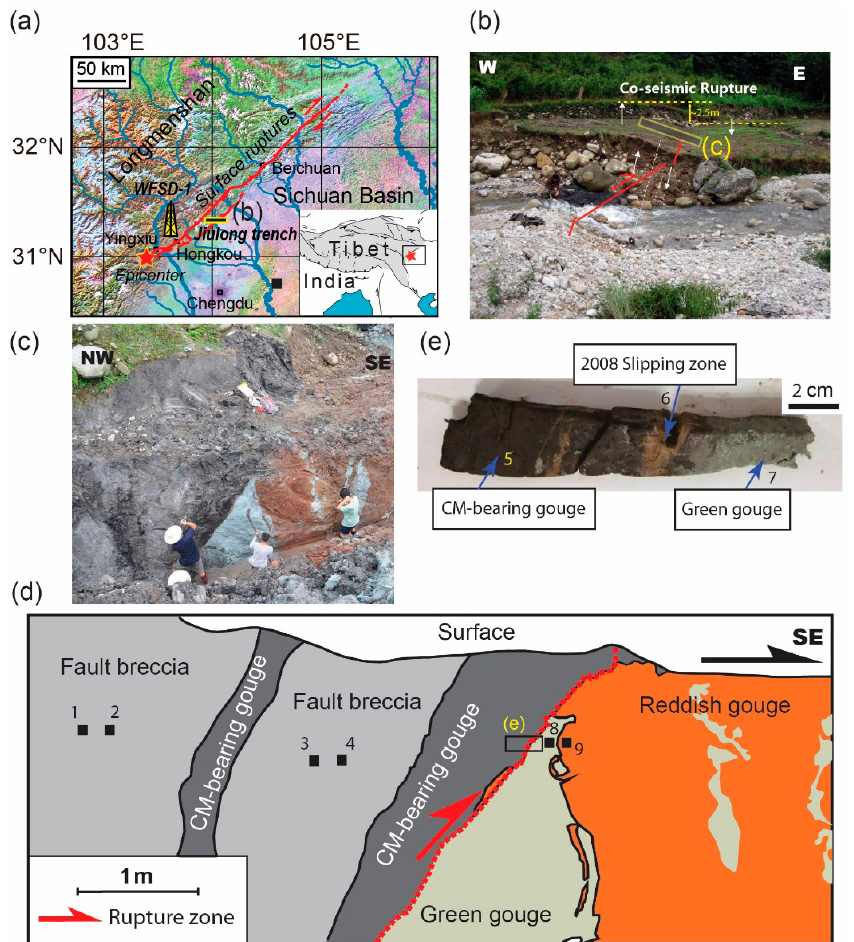
Figure 1. Map and images showing the front Longmenshan fault zone, the coseismic surface rupture zone formed in the 2008 M W -7.9 Wenchuan earthquake in China, the trench of the Anxian-Guanxian fault, and a collected fault sample. ( a ) The two surface rupture zones associated with the M W -7.9 earthquake and the location of the Wenchuan Earthquake Fault Scientific Drilling Project (WFSD-1) site. The red star is the epicenter of the main shock. The inset is a schematic of the Tibetan Plateau. The yellow area shows the location of ( b ). ( b ) The Anxian-Guanxian surface rupture outcropped at the town of Jiulong. The largest vertical displacement along the Anxian-Guanxian fault surface rupture was approximately 4 m and located in the Qingquan village; the vertical offset was approximately 2.5 m at the trench site during the Wenchuan earthquake. The yellow rectangle shows the trench construction site of ( c ). ( c ) Image of the trench. ( d ) Sketch of the trench; the numbers label the samples, and the black box shows the sampling location of sample numbers 5, 6 and 7. ( e ). An image of a sample.